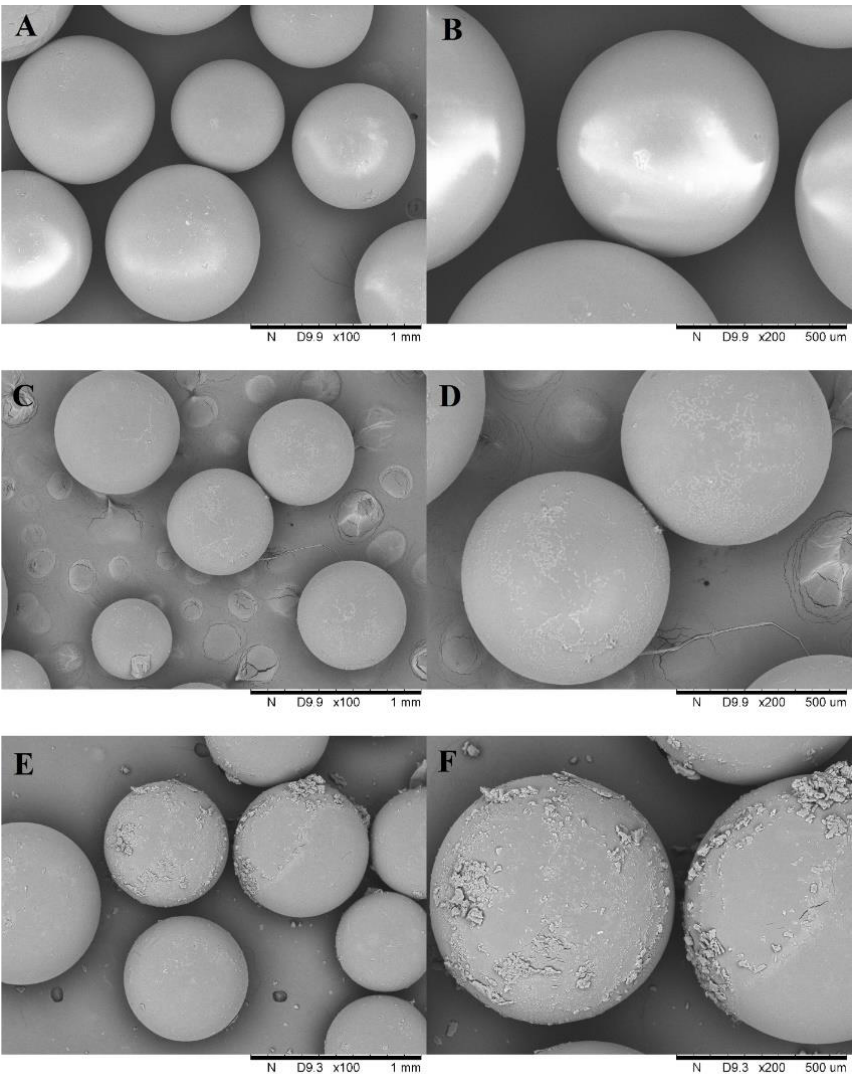
Figure 1. Scanning electron microphotographs of ( A , B ) beads of Lewatit VP OC 1600 ( × 100, × 200), ( C , D ) crude solution of Y. lipolytica enzymes immobilized on Lewatit VP OC 1600 ( × 100, × 200), and ( E , F ) liquid lipase Novozym 51032 immobilized on Lewatit VP OC 1600 ( × 100, × 200).